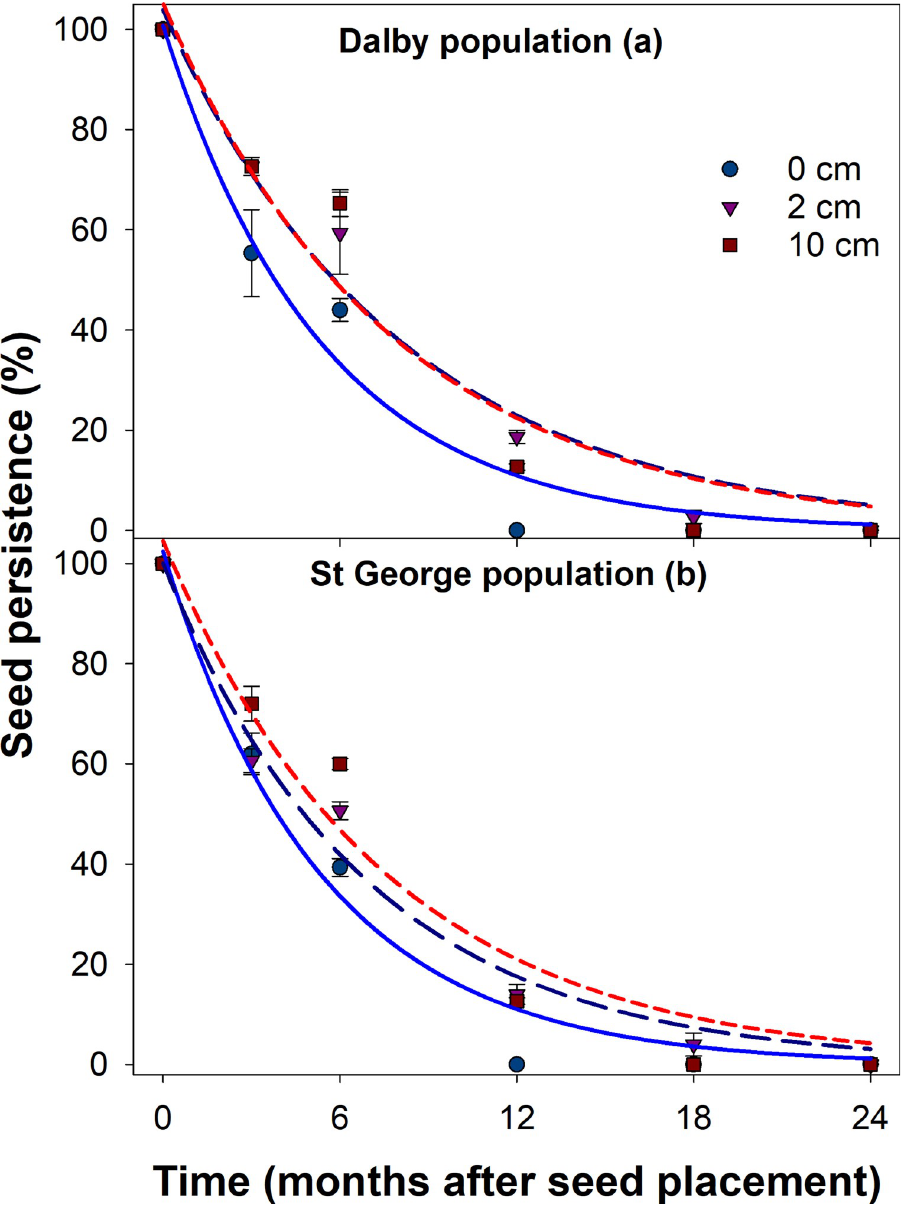
Fig 2. Effect of burial depth and burial duration on seed persistence (%) of two populations [Dalby (a) and St George (b)] of Chloris truncata . Bars are the standard error of means (n = 3). The curves represent an exponential decay model (red, 0 cm; yellow, 2 cm; and blue, 10 cm) and parameter estimates of the model are shown in Table 1.